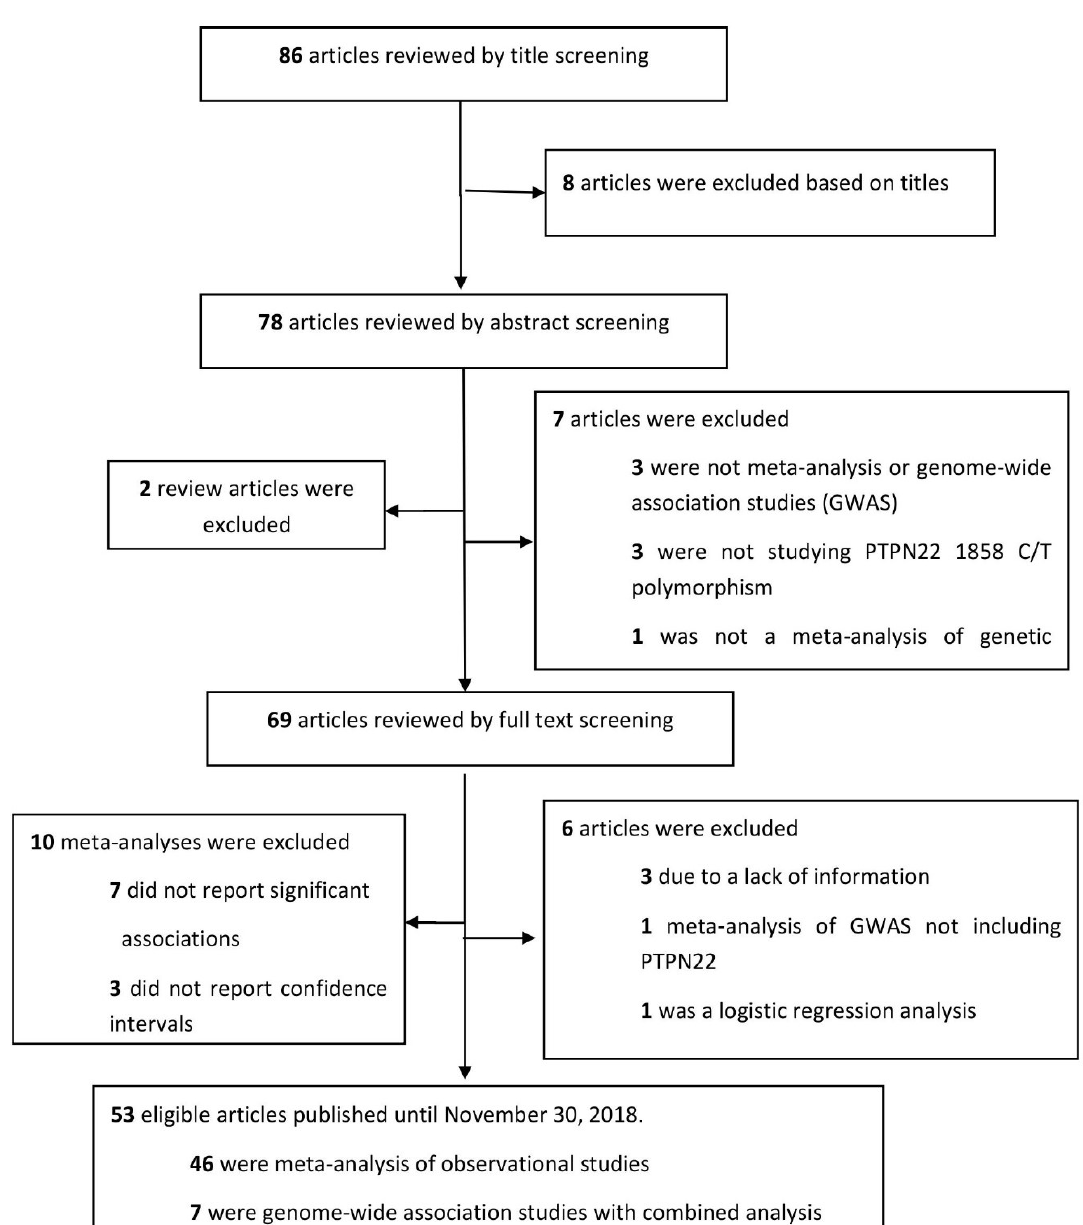
Figure 1. The process of the systematic search performed to study the PTPN22 polymorphism in autoimmune or autoimmunity-related diseases.